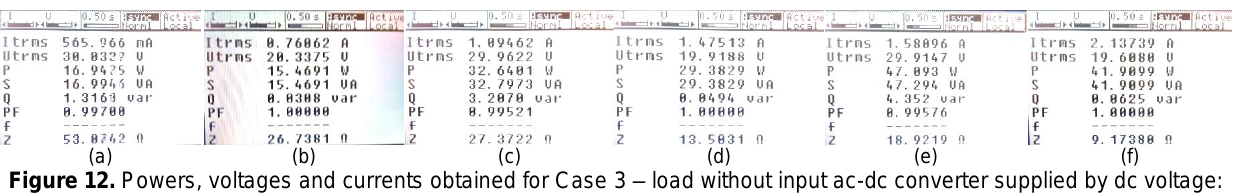
Figure 12. Powers, voltages and currents obtained for Case 3 – load without input ac-dc converter supplied by dc voltage: (a) Input and (b) Output values for R o = 26 Ω; (c) Input and (d) Output values for R o = 13 Ω; (e) Input and (f) Output values for R o =